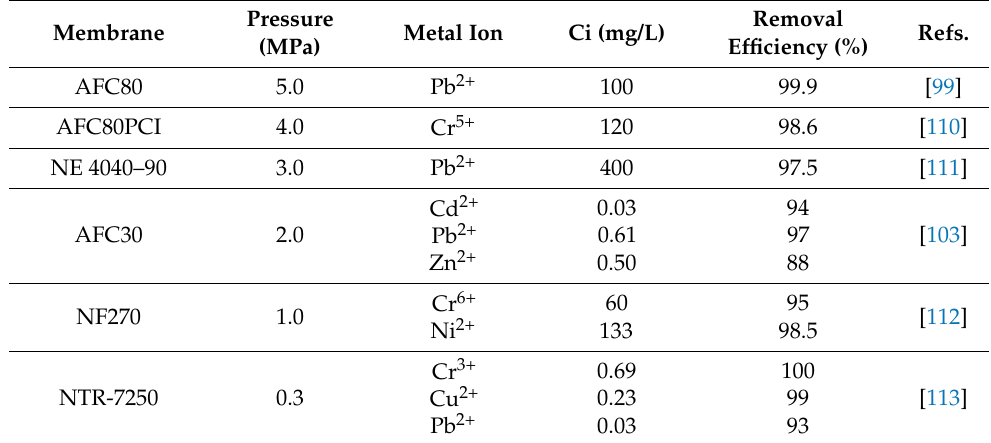
Table 4. Performance of commercial NF membranes in the removal of heavy